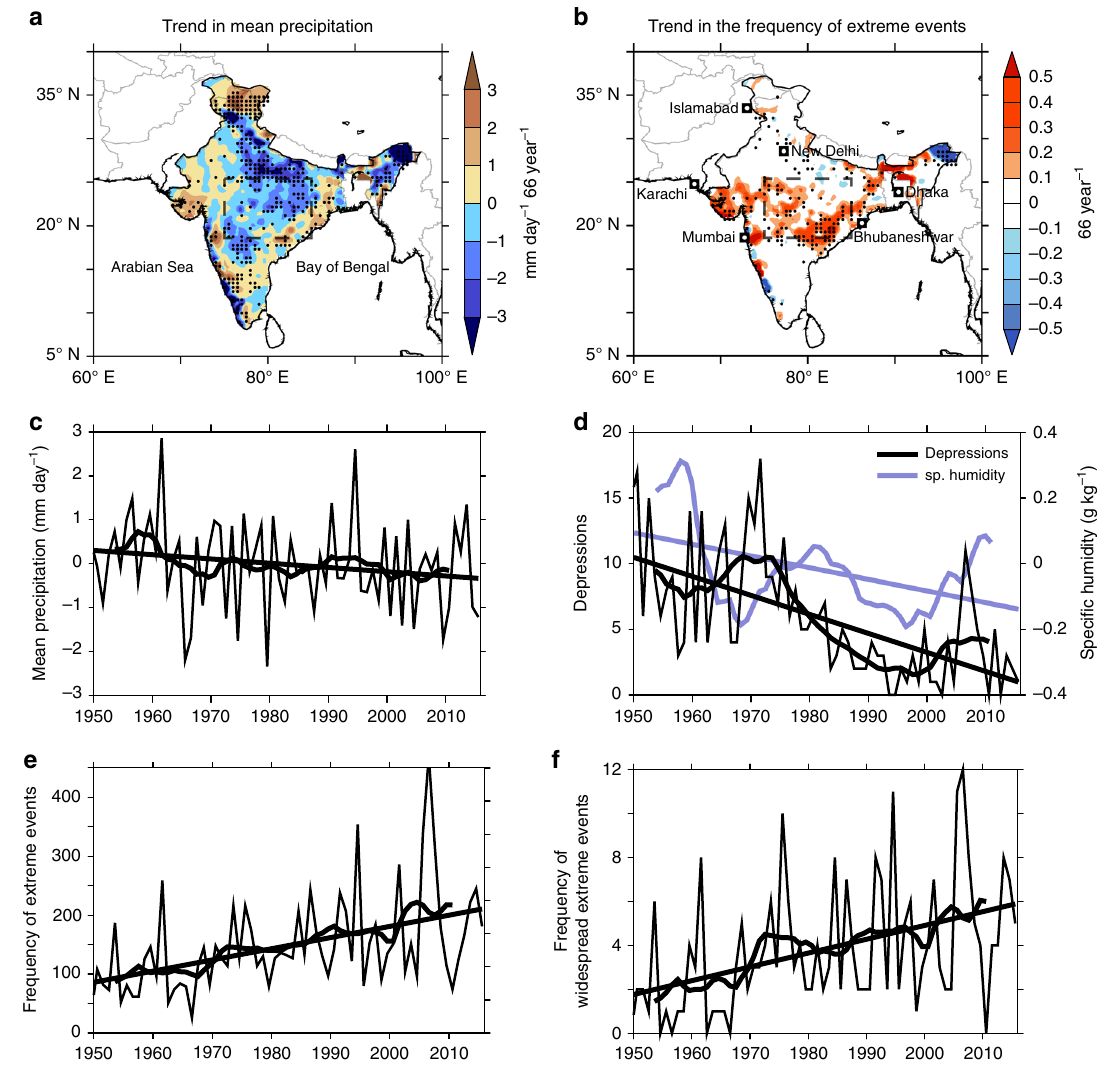
Fig. 1 Trends in summer mean and extreme precipitation during 1950 – 2015. Observed trend in summer a mean precipitation anomalies (mm day − 1 66 year − 1 ) and b the frequency (66 year − 1 ) of extreme precipitation events (precipitation ≥ 150 mm day − 1 ). Mean precipitation for the season is 8.1 mm day − 1 . Time series of c of precipitation (mm day − 1 ), d speci fi c humidity (1000 – 200 hPa) anomalies (g kg − 1 ), and the number of days with low-pressure systems over central India and e frequency of extreme rain events (number of grid cells exceeding 150 mm day − 1 per year) over central Indian subcontinent (75° – 85° E, 19° – 26° N, inset boxes in a , d ). f Time series of the frequency of widespread extreme events (number of days when the extreme